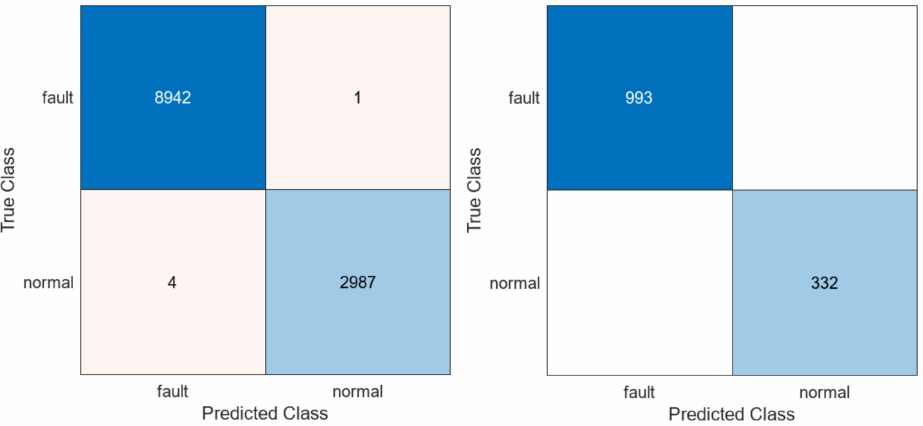
Figure 9. Confusion matrix of a single trained classificator: validation data ( left ) and test data ( right